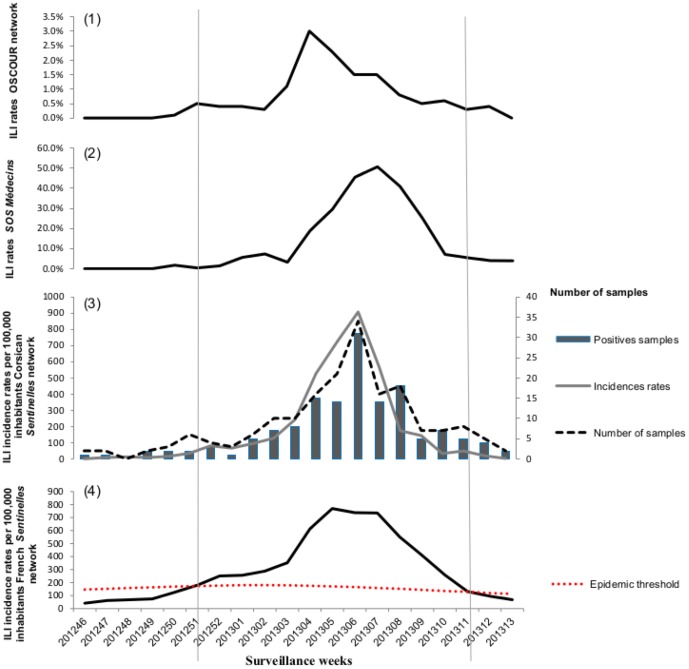
Temporal distribution of influenza-like illness (ILI) consultation rates from November 2012 (week 46) to April 2013 (week 14) by surveillance networks in Corsica.From top to bottom, (1) Weekly rates (black line) of J09 to J11 diagnostics estimated over the totality of number of visits coded per week at hospital emergencies (OSCOUR network), (2) Weekly rates (black line) of R80 Influenza/R80 ILI diagnostics estimated over the totality of number of visits coded per week by GPs of the emergency general practice network (SOS Médecins). (3) ILI incidence rates (grey line) per 100 000 inhabitants and weekly distribution of ILI samples positives (histogram bars) to at least one respiratory viruses analyzed (GPs of the Corsican Sentinelles network). (4) ILI incidence rates (black line) per 100 000 inhabitants (GPs of the French Sentinelles network) and epidemic threshold (red dotted line) calculated by a periodic regression on model applied to the former observed data (Serfling'method) [44].